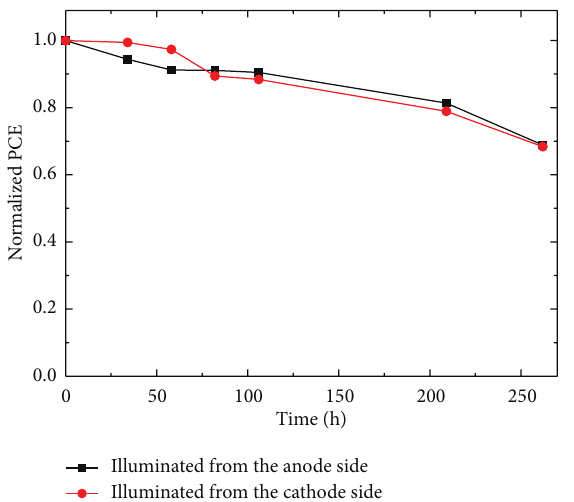
Figure 6: The variation of the normalized PCE with